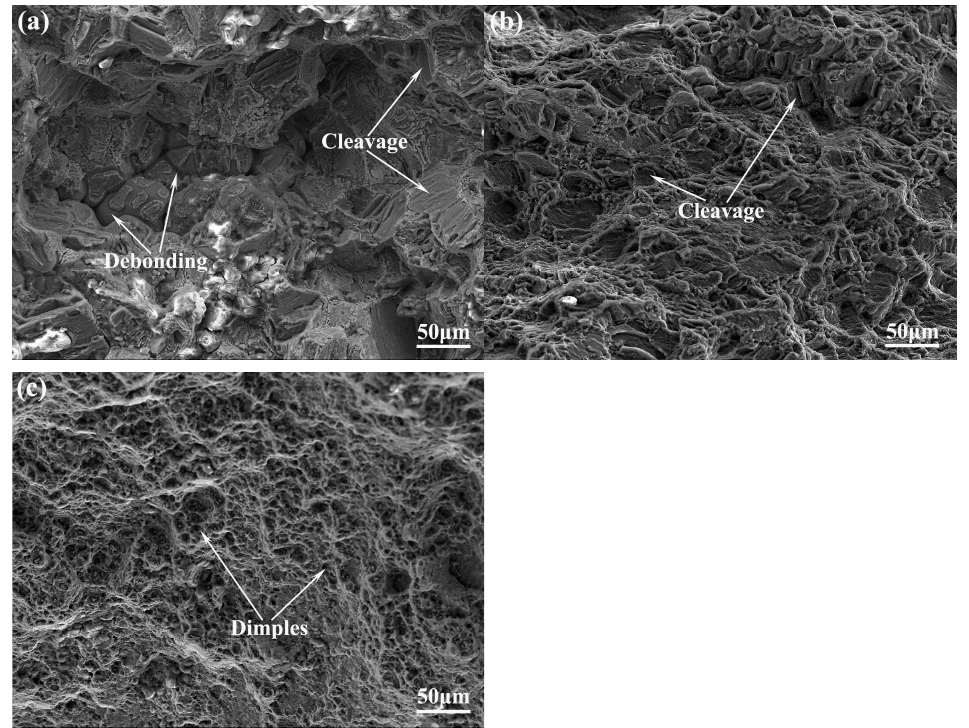
Figure 10. Fracture surface of the Mg–Zn–Y–Nd alloy with different processing: ( a ) heat treatment, ( b ) one-pass hot extrusion, ( c ) two-pass hot extrusion.